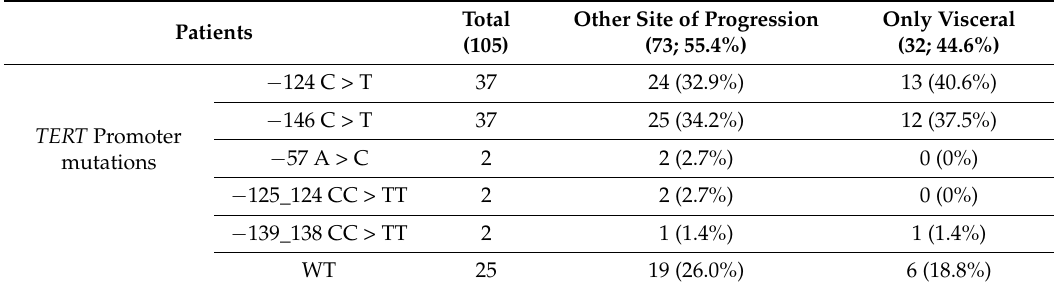
Table 2. TERT promoter mutations details based on pattern of first relapse.